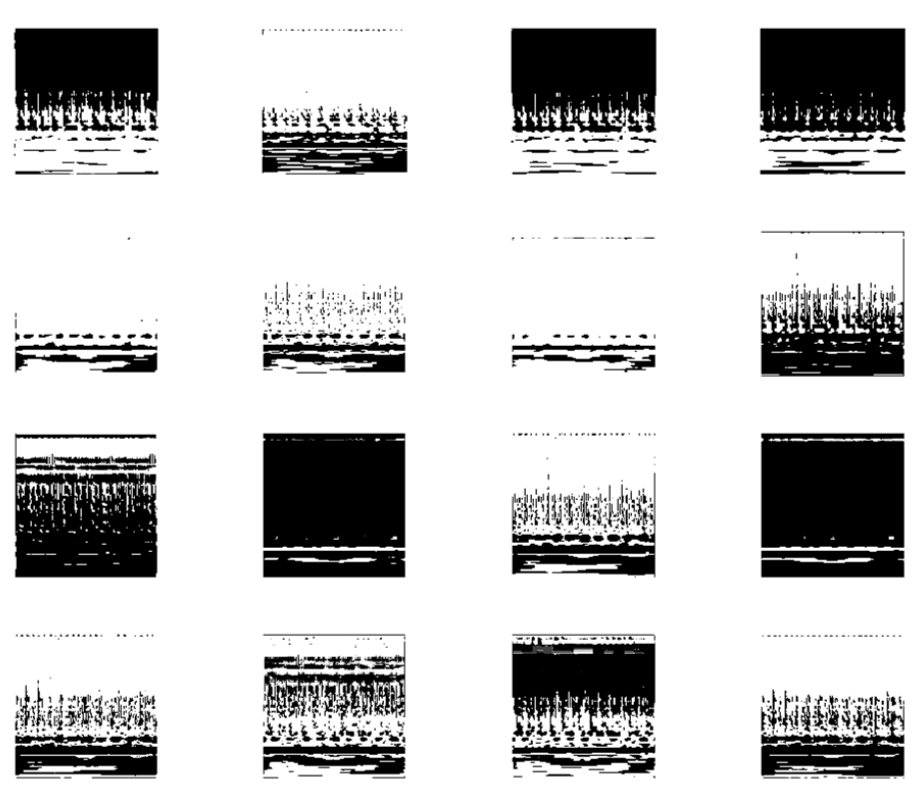
Figure 7. An example of the feature map realized by 16-filter of the 1st convolution layer. Herein, it is observed that each filter is realizing different features of the input image, which are supplied to the next layers for further processing. The convolution process is mathematically described by Equation